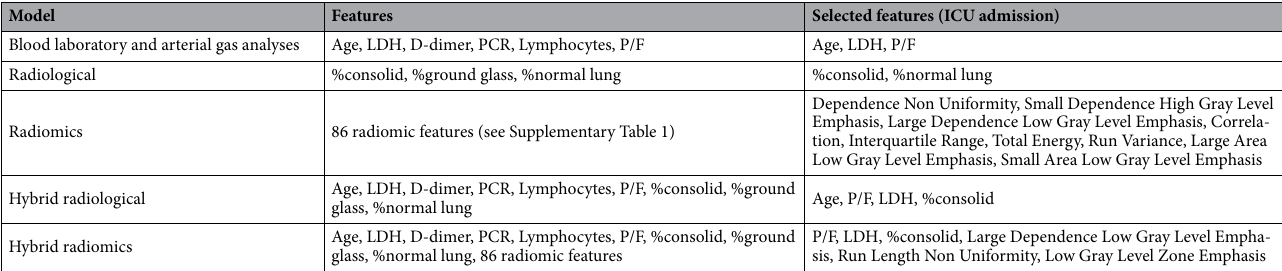
Table 2. Features a priori considered and features selected by GLMNET for their relevance in predicting ICU admission in five models. P/F = ratio between the arterial partial pressure of oxygen [PaO 2 ] measured (in mmHg) by blood gas analysis and fraction of inspired oxygen [FiO 2 ]; %consolid = percentage of consolidated lung; %ground glass = percentage of lung exhibiting ground glass opacities density; %normal lung = percentage